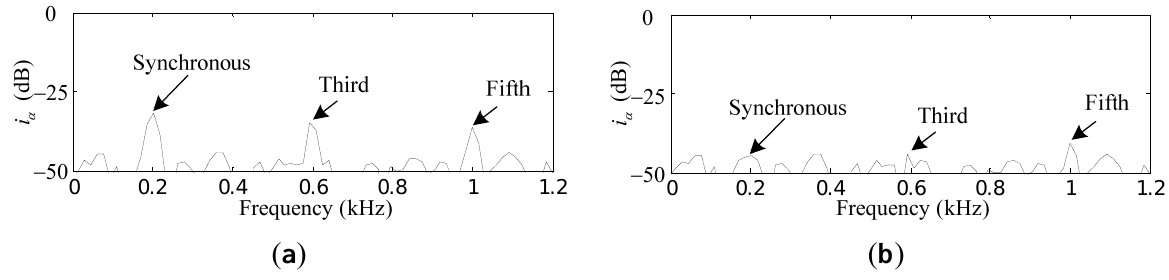
Figure 16. Simulation results of i α : ( a ) before harmonic current suppression; ( b ) after harmonic current